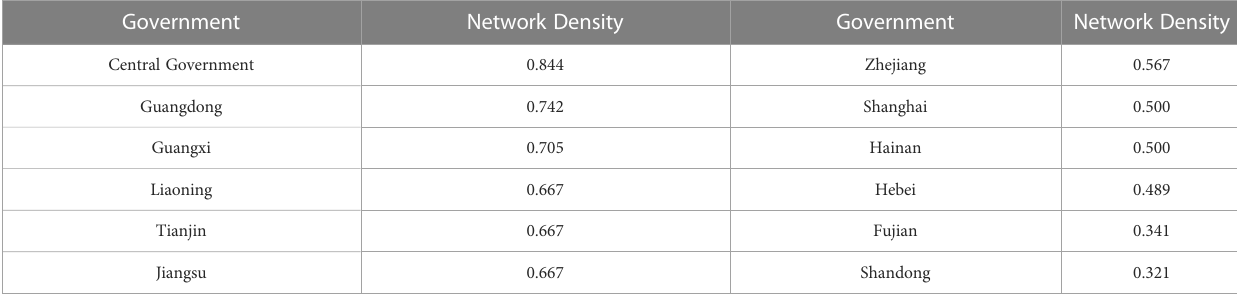
TABLE 1 Departmental synergy network